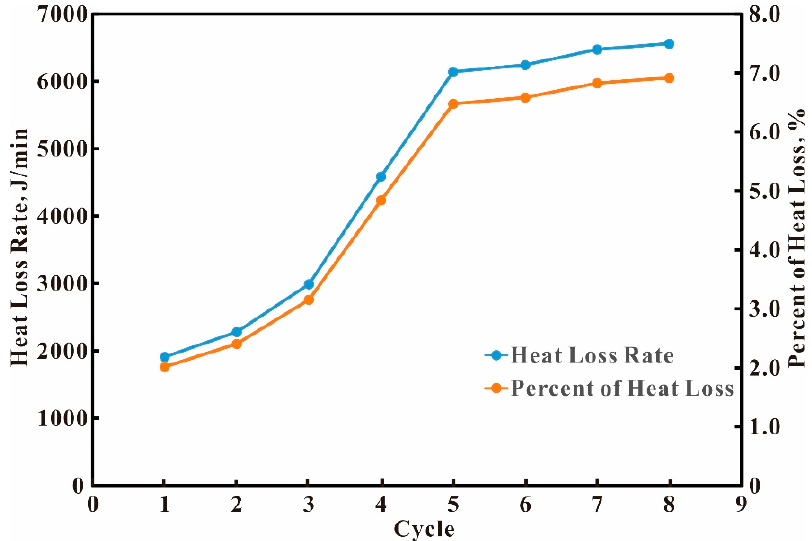
Figure 11. Heat loss rate and percentage in each cycle.